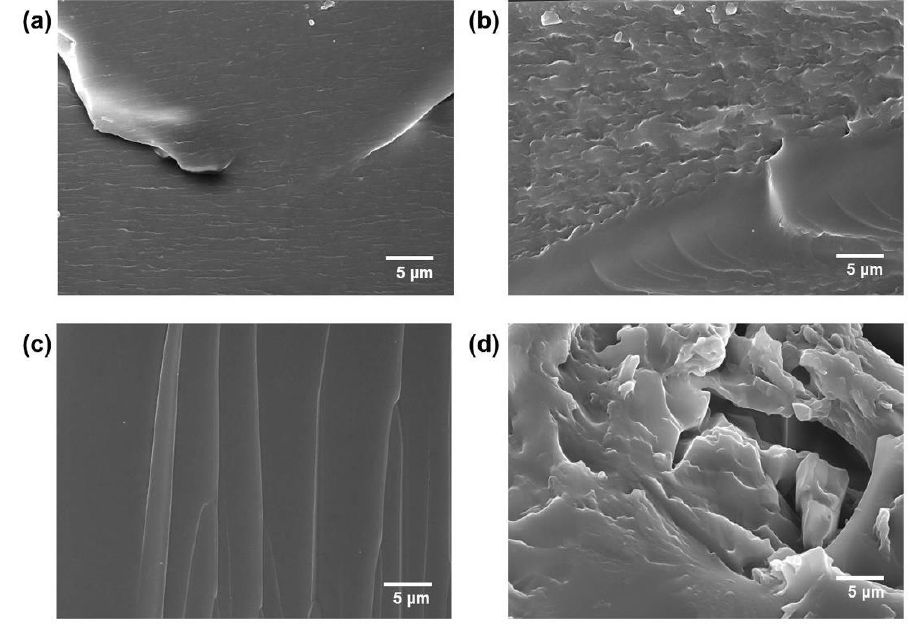
Figure 5. SEM images of ( a ) FEEMA64_mGO0.030 wt%, ( b ) FEEMA64_mGO0.050 wt%, ( c )